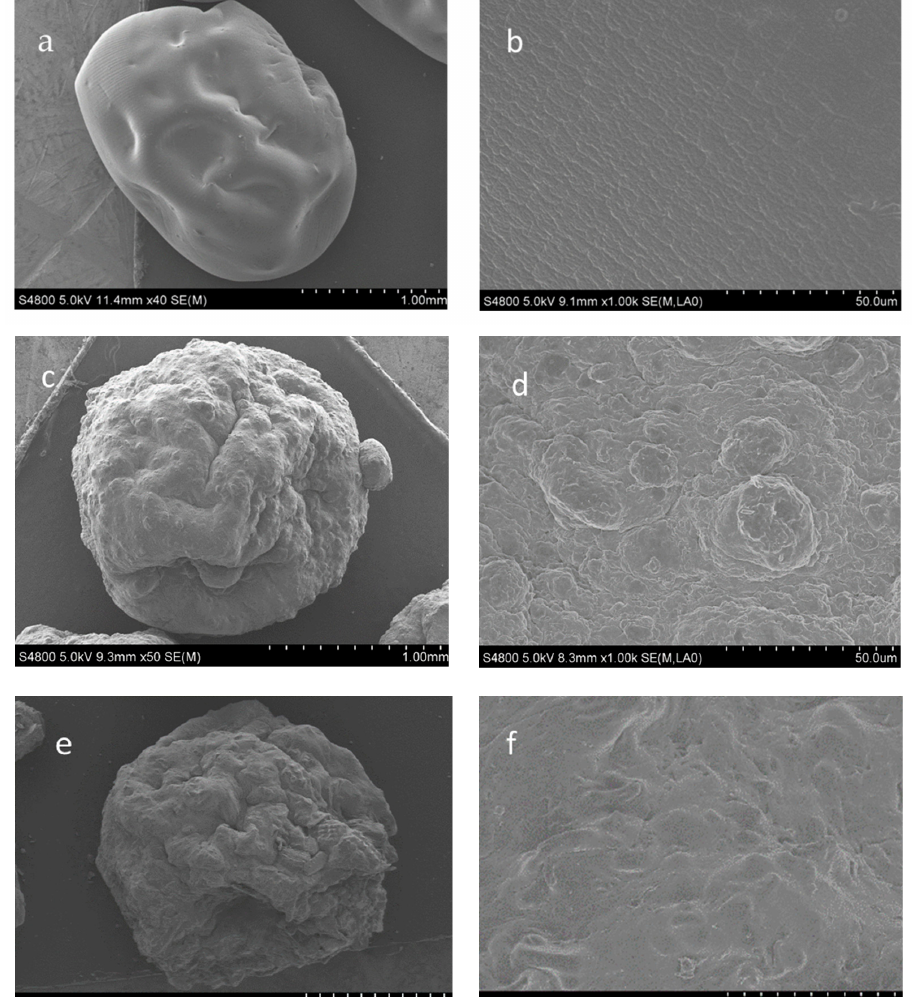
Figure 2. Scanning electron micrographs of starch-alginate based beads: ( a , b ) Starch–alginate beads at different magnifications { a × 40; b × 1000}. ( c , d ) Starch–alginate–kaolin beads at different magnifications { c × 50; d × 1000}. (e, f) Starch–alginate–rice husk powder beads at different magnifications { e × 40; f × 1000}.